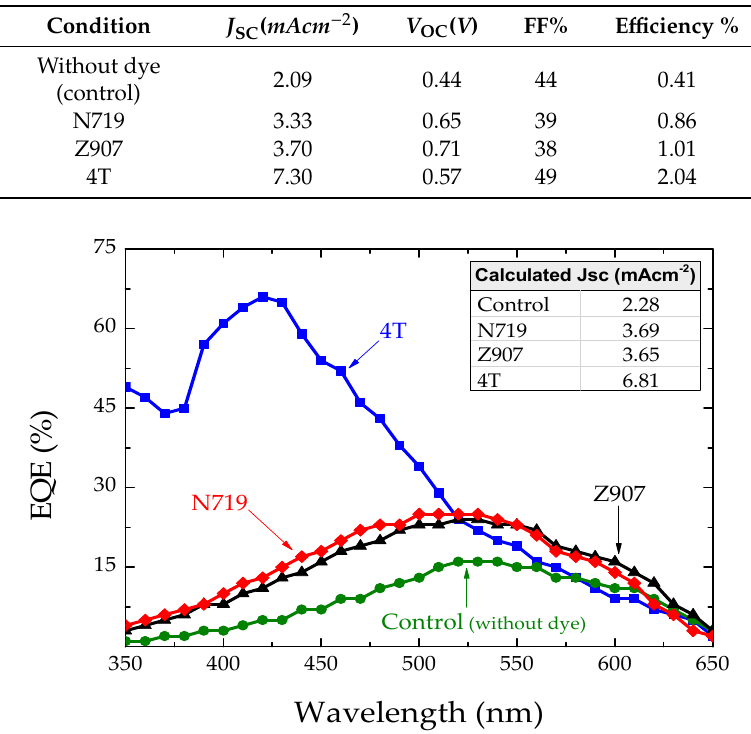
Figure 4. ( a ) J-V characteristics of the fabricated TiO 2 /P3HT and dye-modified TiO 2 /P3HT solar 161 cells under simulated irradiation of 100 mW cm –2 (1 sun) with Air Mass 1.5 filter and ( b ) semi-log J-V 162 plot of the solar cells in dark. The complete structure of control device is ITO/TiO 2 /P3HT/Au, and the 163 dye modified cells have the structure ITO/TiO 2 /dye/P3HT/Au. Here, dyes Z907, N719, and 4T were 164 used as the interface modifiers. 165 Table 1. Current density vs. voltage measurement data for the control device and other corresponding 166 dye-modified devices. 167